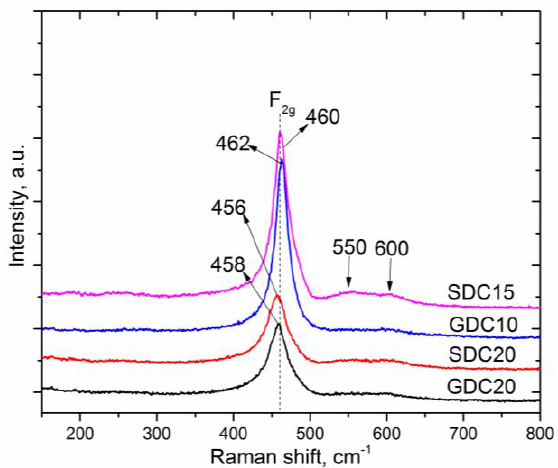
Figure 9. Raman spectra of different compositions of Gd- and Sm-doped ceria thin films deposited on SiO 2 substrates at different deposition rates, i.e., GDC10 and GDC20 at 1.2 nm/s, SDC15 and SDC20 at 0.8 nm/s.